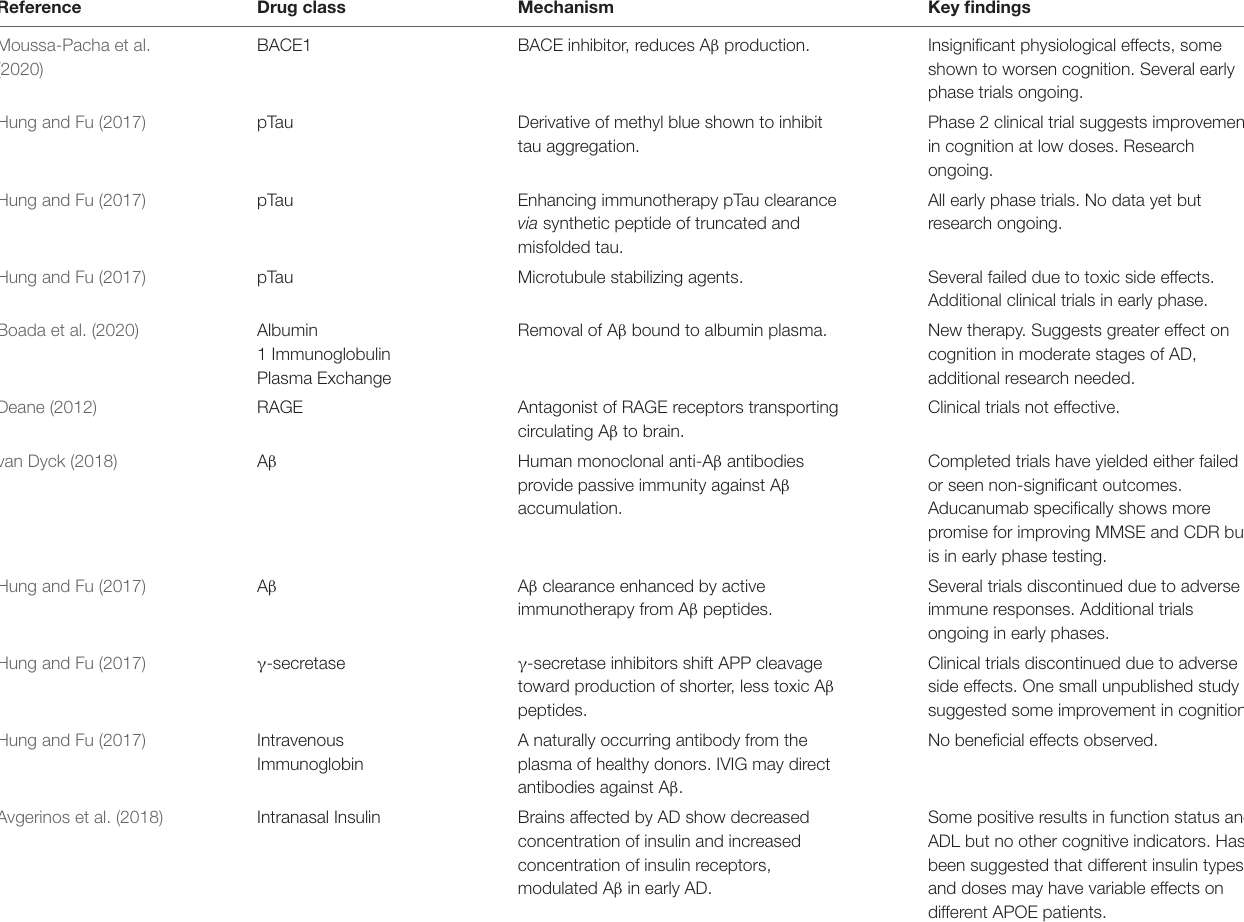
TABLE 3 | Major anti-amyloid AD treatments under